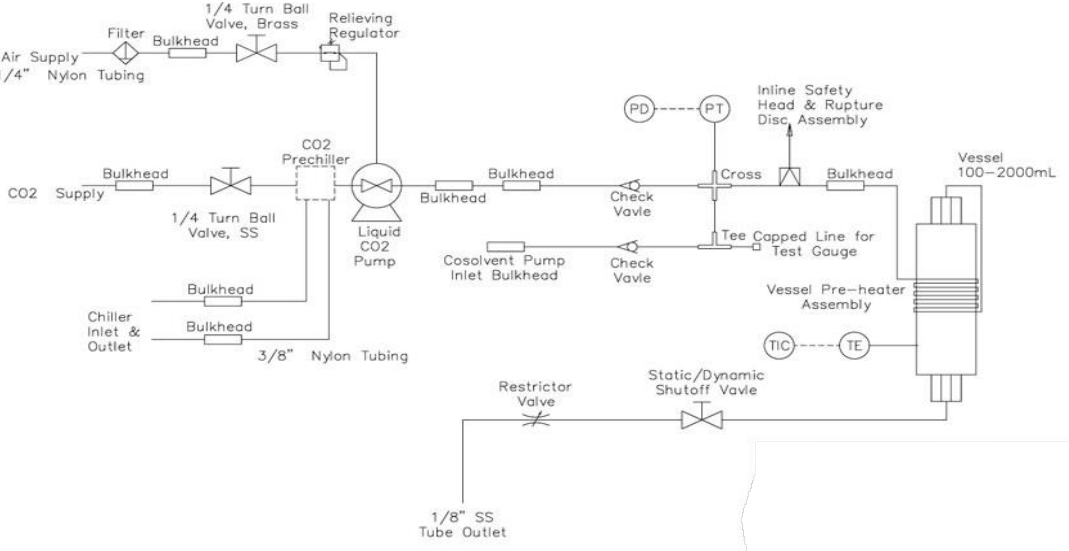
Figure 9. Diagram of supercritical extraction equipment [49].